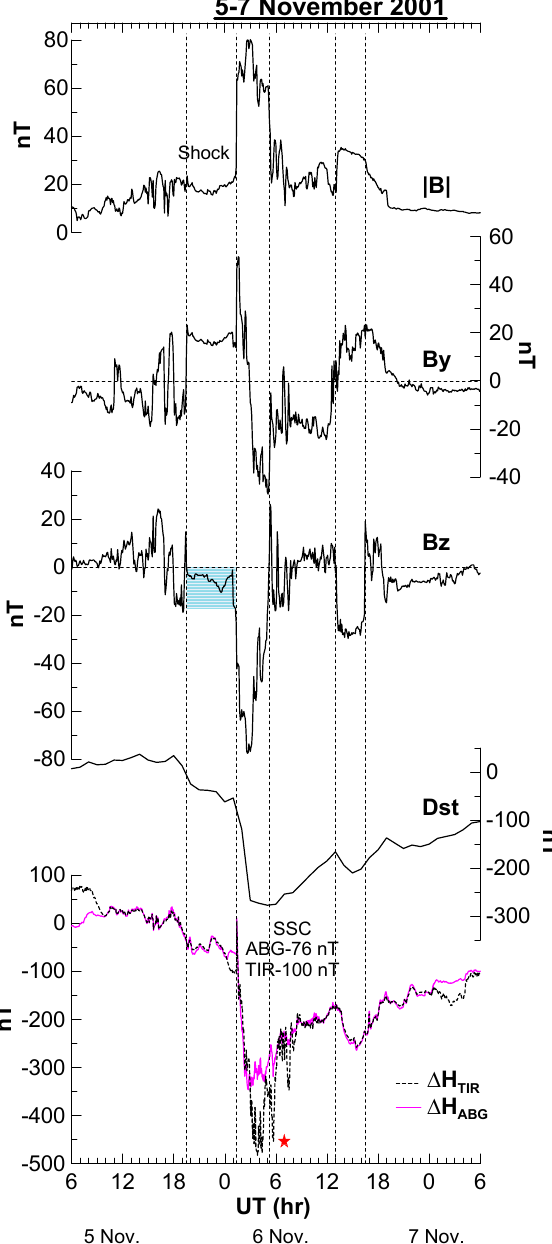
Fig. 4. From top to bottom: IMF | B | , IMF B y , IMF B z , hourly av- eraged D st index, 1-min digital magnetic data 1H ABG and 1H TIR for 5–7 November 2001. Red star (*) depicts local